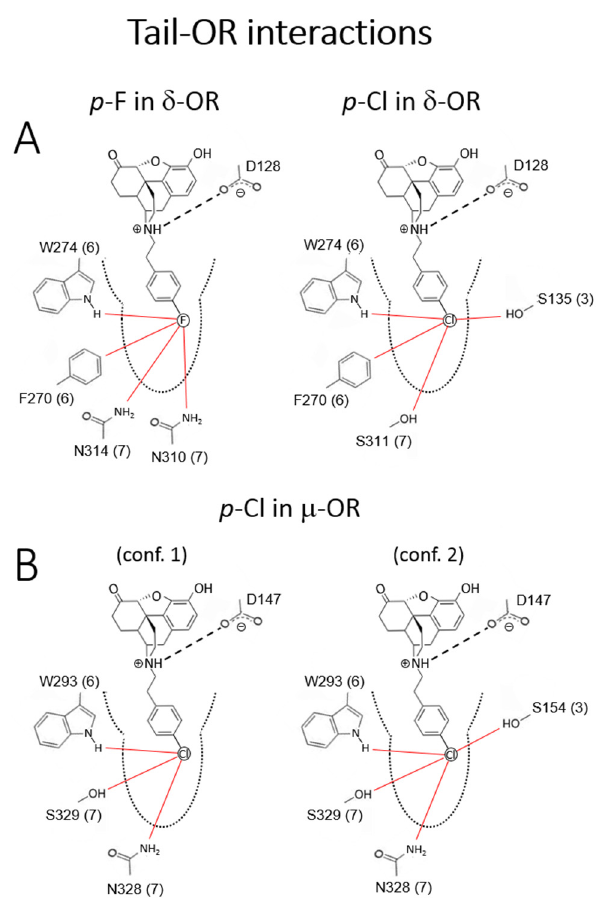
Figure 2. Critical tail-OR interactions of p -F ( 2e ) and -Cl ( 2i ) substituents. ( A ) p -F (weak partial DOR agonist) vs. p -Cl (potent full DOR agonist); only one of the two conformers of each ligands are shown (see text); ( B ) p -Cl (potent partial MOR agonists); the two conformers shown. The red lines represent frequent, statistically significant interactions that were obtained from the dynamic simulations. Sequence numbering as in the corresponding ORs.